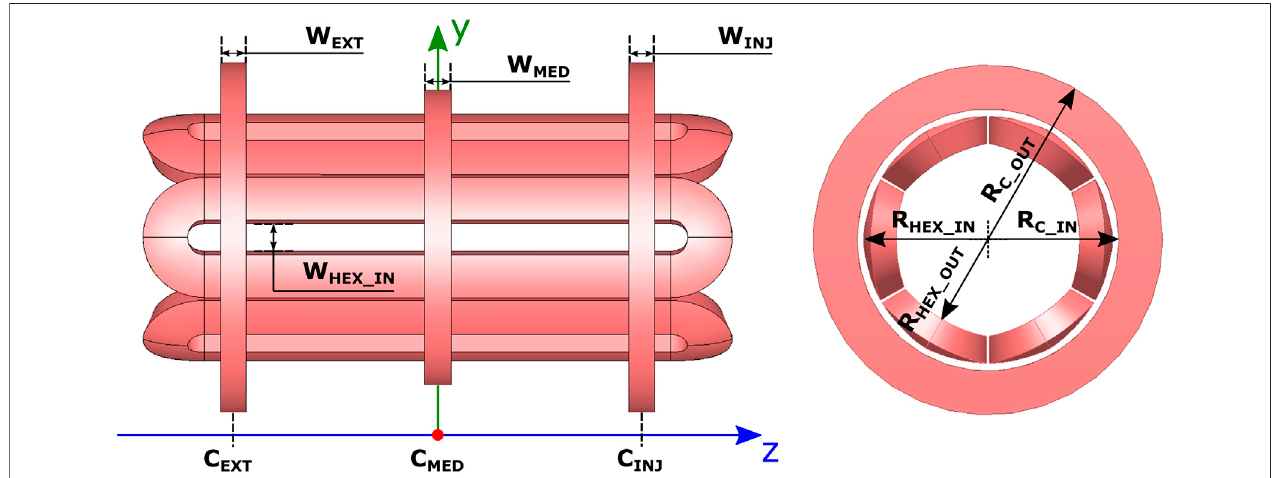
FIGURE 3 | Side and front view of the simulated magnetic system with dimensional parameters. Note: iron yoke does not appear in the picture.